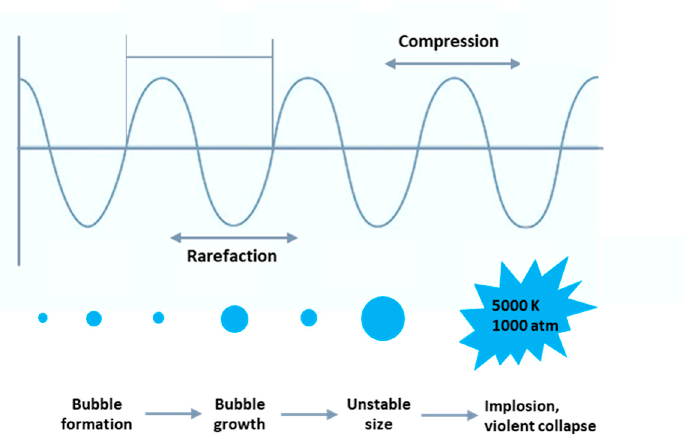
Figure 3. Mechanism of the cavitation phenomenon creation.